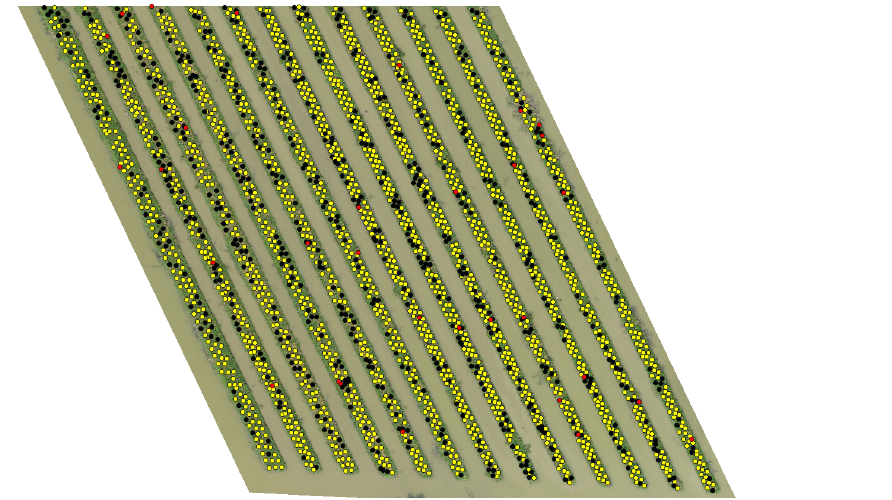
Fig 10. Final detection on ROI of 60m altitude variant.